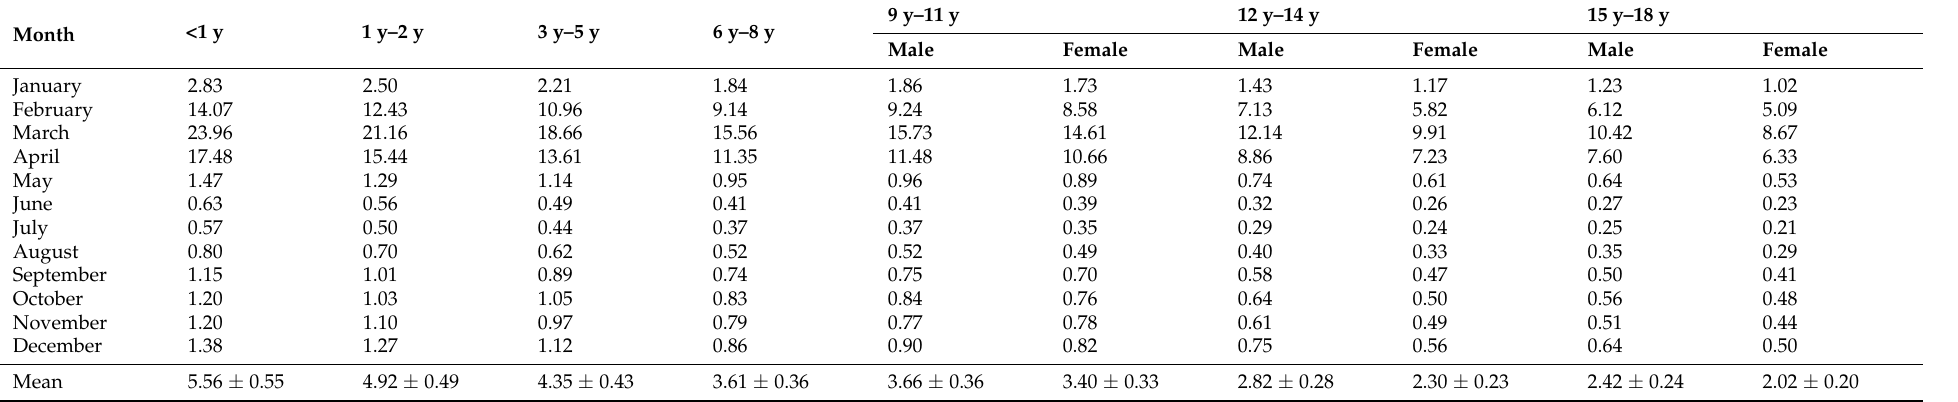
Table 6. Maximum of the monthly means of the HQ related to PM 2.5 according to the different age groups of children during